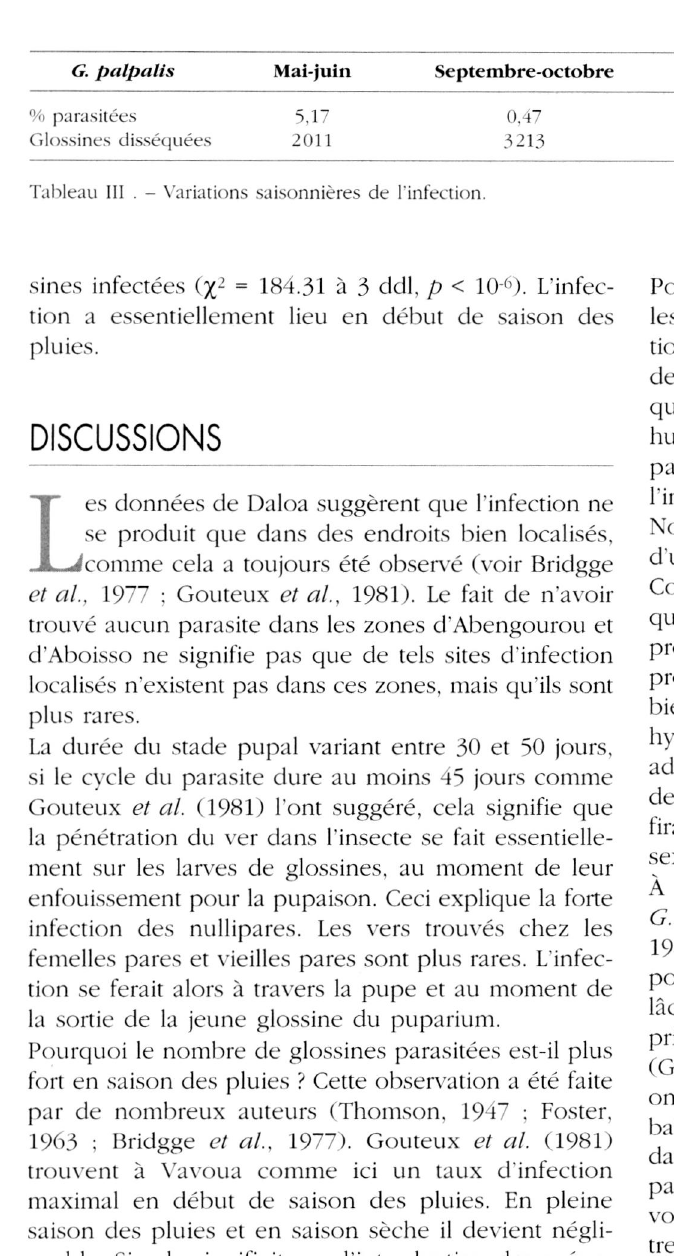
Tableau III . - Variations saisonnières de l'infection.